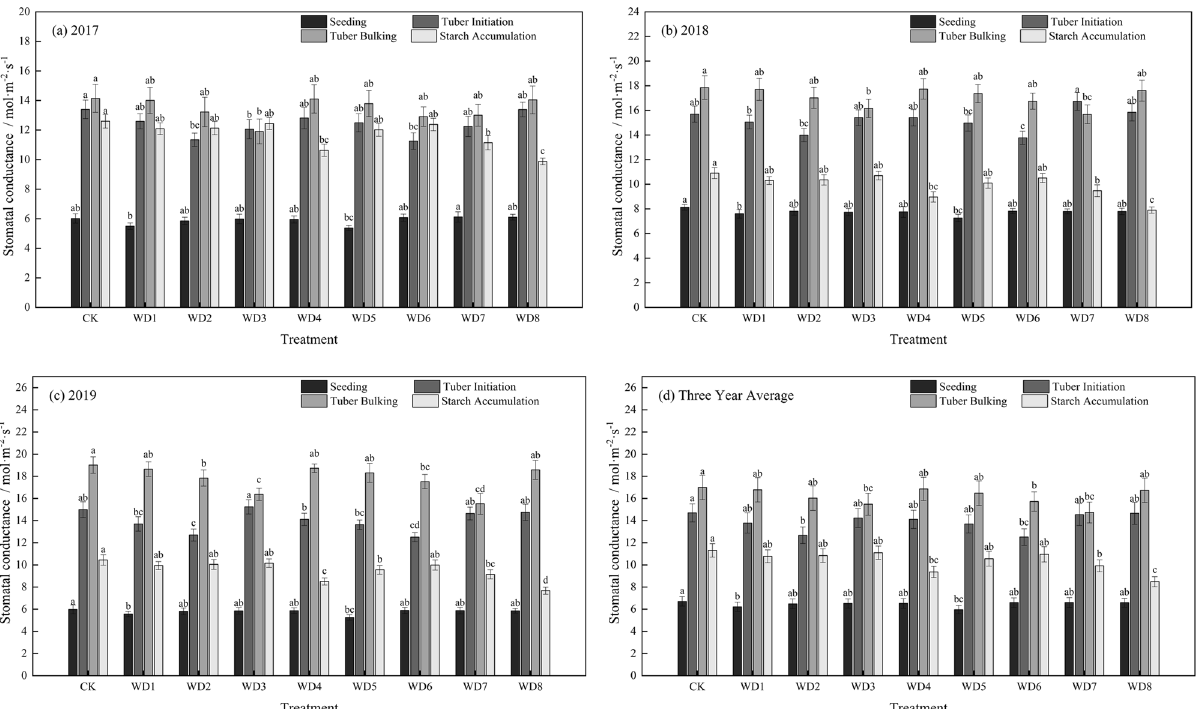
of potato leaf. The irrigation treatments were conventional irrigation (CK) and mild or moderate water deficit during each of four stages of potato growth. Mild deficit was in treatments WD1 (seedling), WD2 (tuber initiation), WD3 (tuber bulking), and WD4 (starch accumulation); moderate deficit was in treatments WD5 (seedling), WD6 (tuber initiation), WD7 (tuber bulking), and WD8 (starch